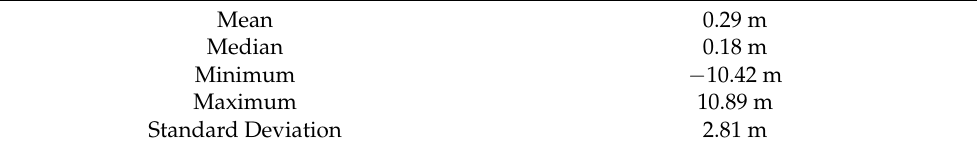
Figure 18. The histogram of the relative residuals calculated based on the 2nd order surface fit.